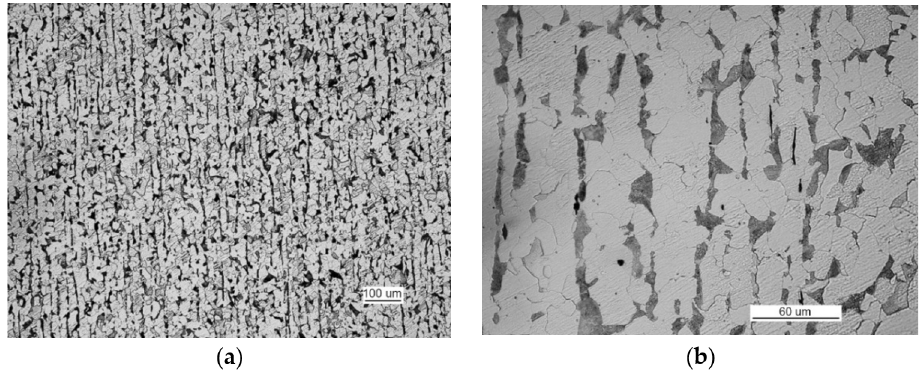
Figure 46. Optical microscopy views (handy-size bulk carrier 30185 DWT): ( a ) the band-like structure of part 2 and ( b ) material structure of part 2 with cementite, silicate, and sulfide precipitates.